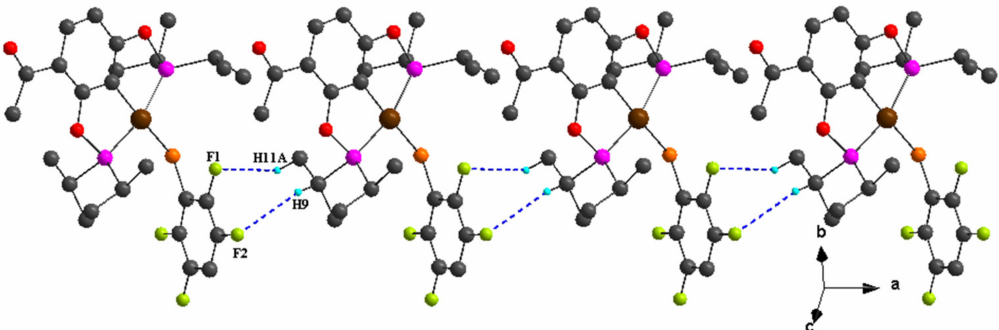
Figure 5. View of the linear array along the (100) direction due the C9–H9 ··· F2 and C11–H11A ··· F1 interactions. Only the hydrogen atoms that participle in the interactions are